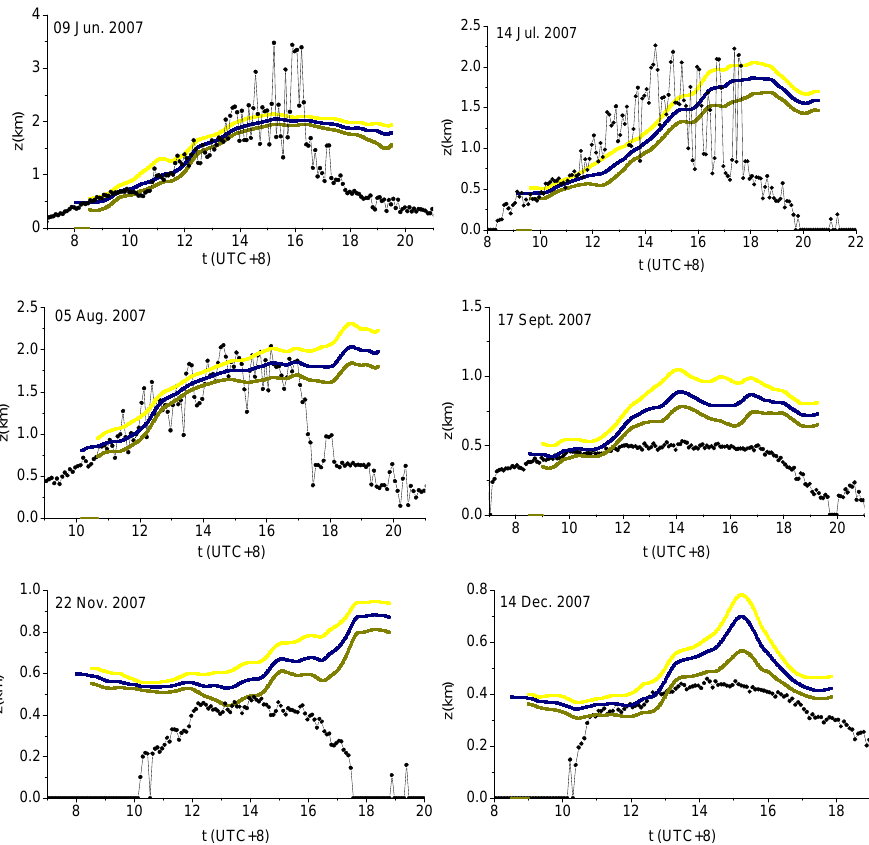
Fig. 5. Comparisons between the BLH from lidar and microwave profiling radiometer for six measurement days in the period of June to Fig. 5: Comparisons between the BLH from lidar and microwave profiling radiometer 493 December 2007. The contents are the same as Fig. 3, except that temperature measurements are not for six measurement days in the period of June to December 2007. The contents are 494 the same as Fig. 3 except that temperature measurements are not showed. 495